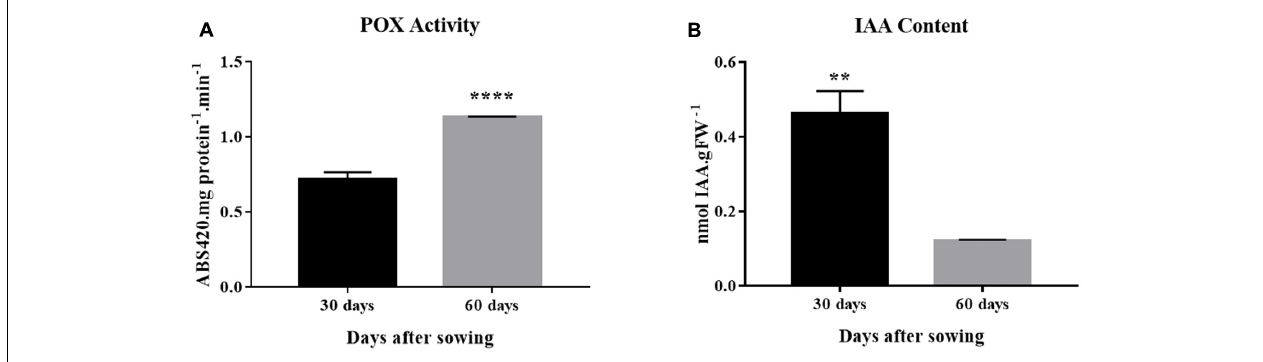
FIGURE 4 | Peroxidase activity and auxin concentration in E. globulus tip cuttings as a function of donor plant age (rooting competence diminishes between 30 and 60 days). (A) Peroxidase (POX) activity. (B) Endogenous indol-3-acetic acid (IAA) concentration. Asterisks indicate significant difference according to Student’s t -test: ∗∗ P ≤ 0.01 and ∗∗∗∗ P ≤ 0.0001. Lines on top of bars represent standard